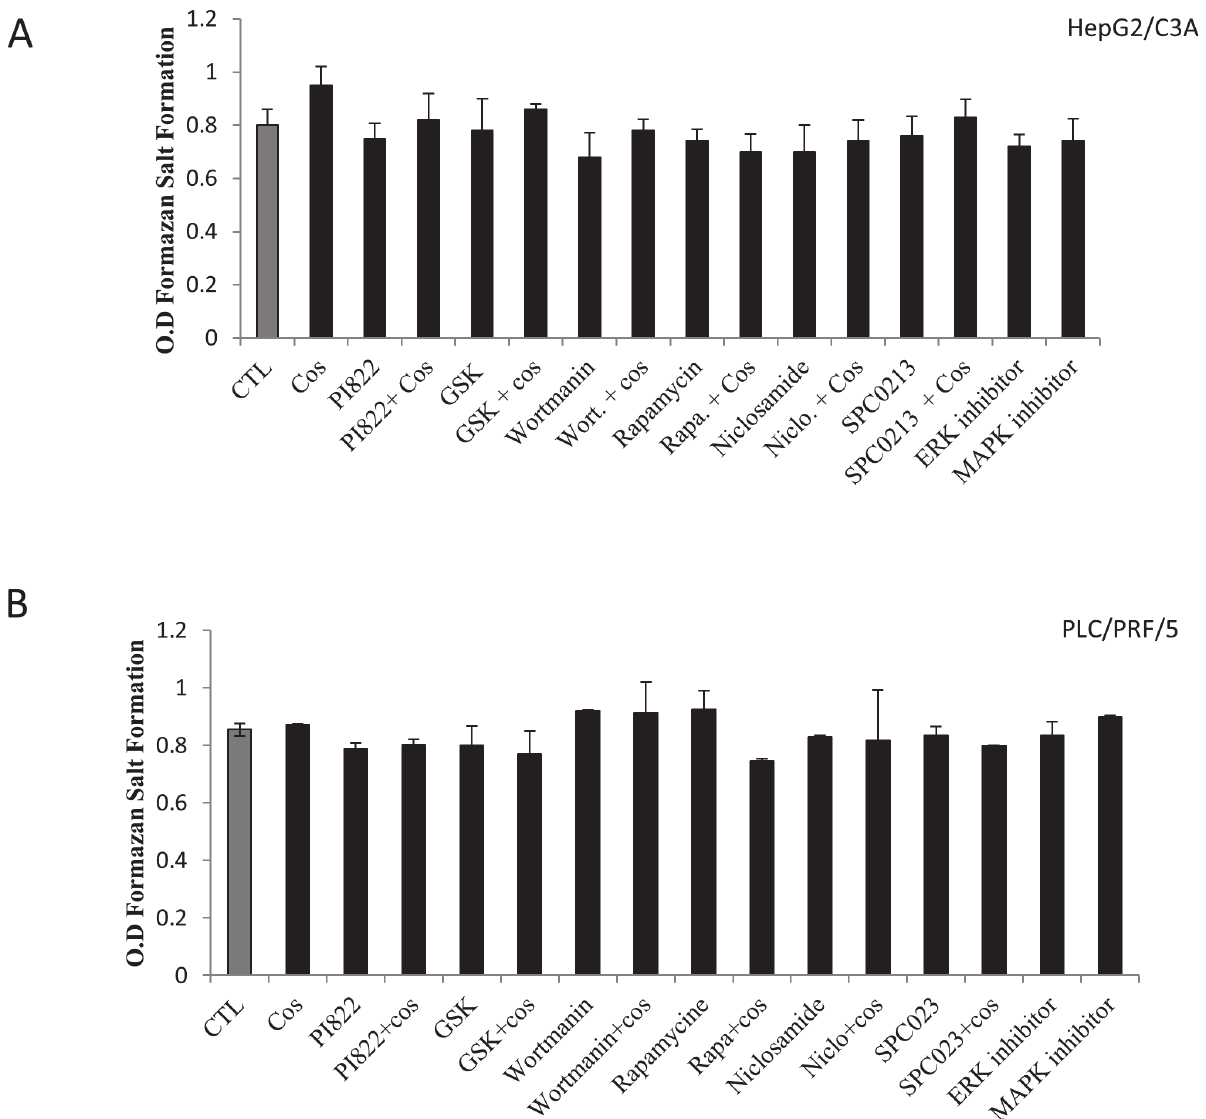
Fig 9. Effect of pathway inhibitors in the presence or absence of costunolide on HepG2/C3A and PLC/PRF/5 cell proliferation. The cells were seeded in a 96-well plate at a density of 10 4 cells/well. At 80% confluence, the cells were treated with inhibitors of the PI3k/mTOR/Akt and MAPK/ERK pathways and costunolide for 48 h. After treatment, 10 μ L of tetrazolium salt was added to 100 μ L of the culture media, and the mixture was incubated for 45 min. The absorbance was then measured using an ELISA reader at 450 nm. As shown in “ Figs A and B ” , the inhibition of PI3K/Akt/mTOR and PKC had no significant effect on the proliferation of cells incubated in the presence or absence of